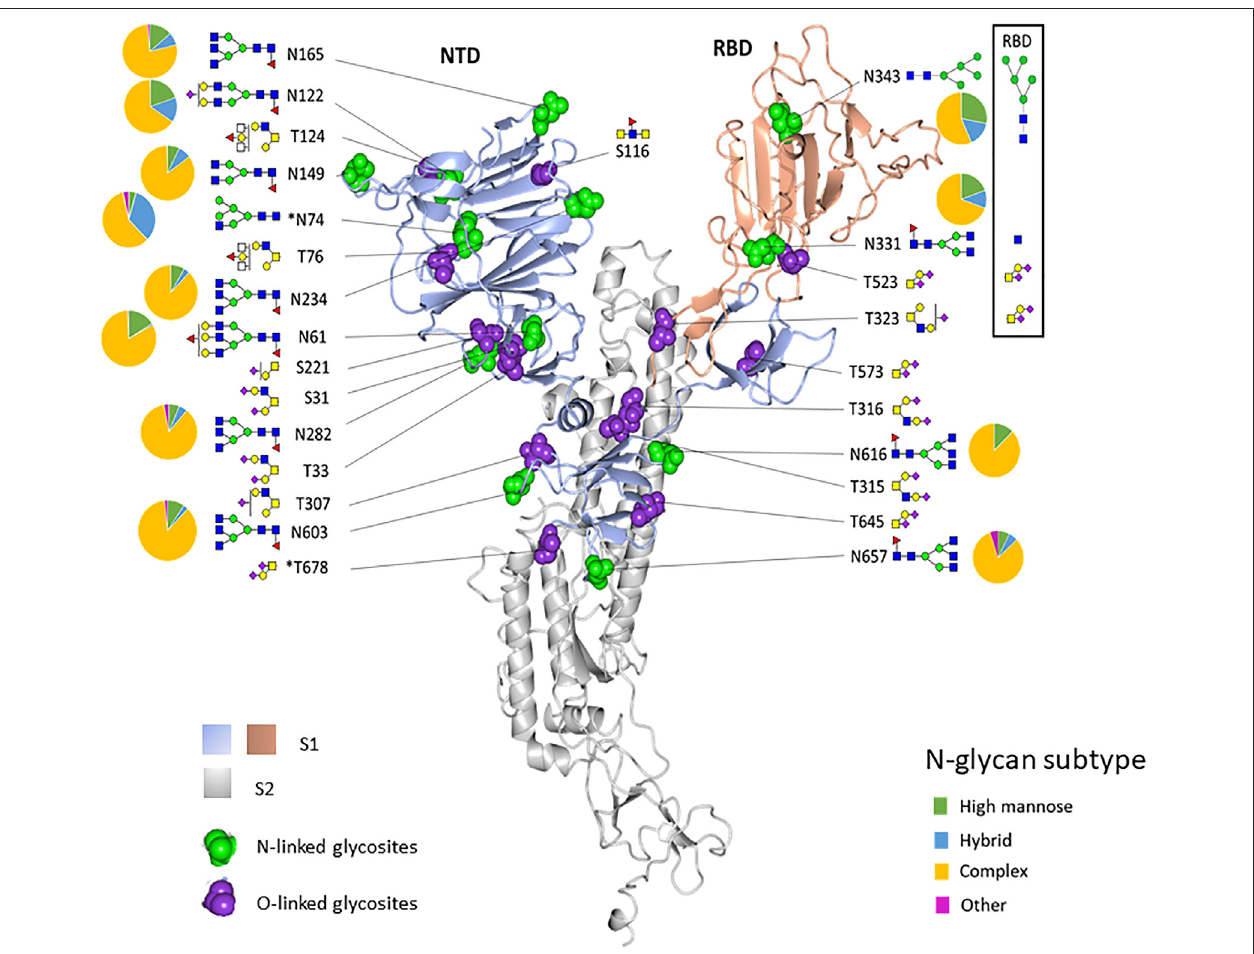
FIGURE 4 | Structure-based mapping of glycans on the recombinant SARS-CoV-2 spike protein. The modeling of experimentally observed glycosylation site compositionsisillustratedonthemonomericSARS-CoV-2spikeglycoprotein(PDB code6ZGG).TheS1subunitiscoloredlightblueandpeach.TheS2subunitisgray. N- and O-linked glycosylation sites are indicated by green balls and purple balls, respectively. Most abundant glycans at each site are shown. Pie charts show the percentage of glycan subtypes at each site. The boxed area shows the predominant glycans and the N-linked glycosylation subtype distribution for the glycans identi fi ed in the recombinant RBD sample. *N74 and T678 are not in the